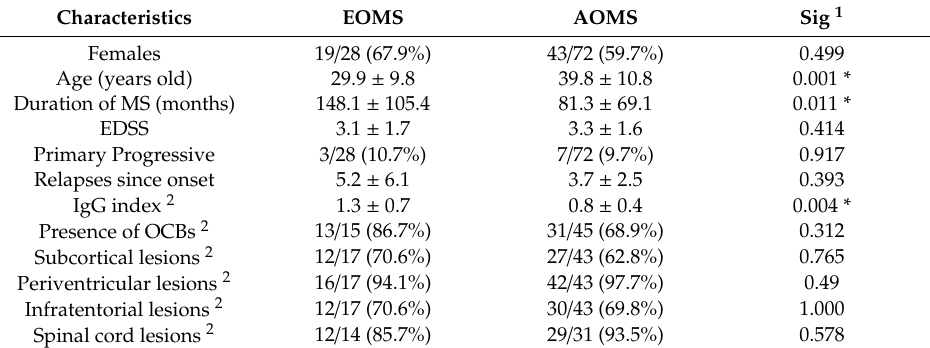
Table 1. Nongenetic Comparisons Between Age of Multiple Sclerosis (MS) Onset